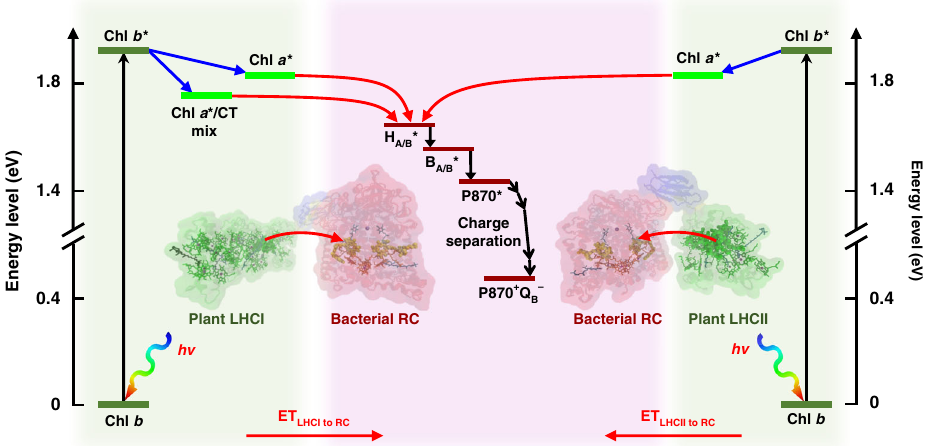
Fig. 5 Solar energy conversion in chimeras. Energy fl ow within LHCII or LHCI is from higher energy chlorophyll b to lower energy chlorophyll a . LHCI also exhibits a red-shifted emissive state with mixed excitonic/charge-transfer (CT) character. Excited state energy entering the RC via the bacteriopheophytins (H A/B ) migrates to the P870 bacteriochlorophylls via the monomeric bacteriochlorophylls (B A/B ), initiating charge separation to form P870 + Q B − . Energy harvested by the carotenoid pigments of LHCII or LHCI (not shown) would transferred to the RC via their chlorophylls through fast internal relaxation 61